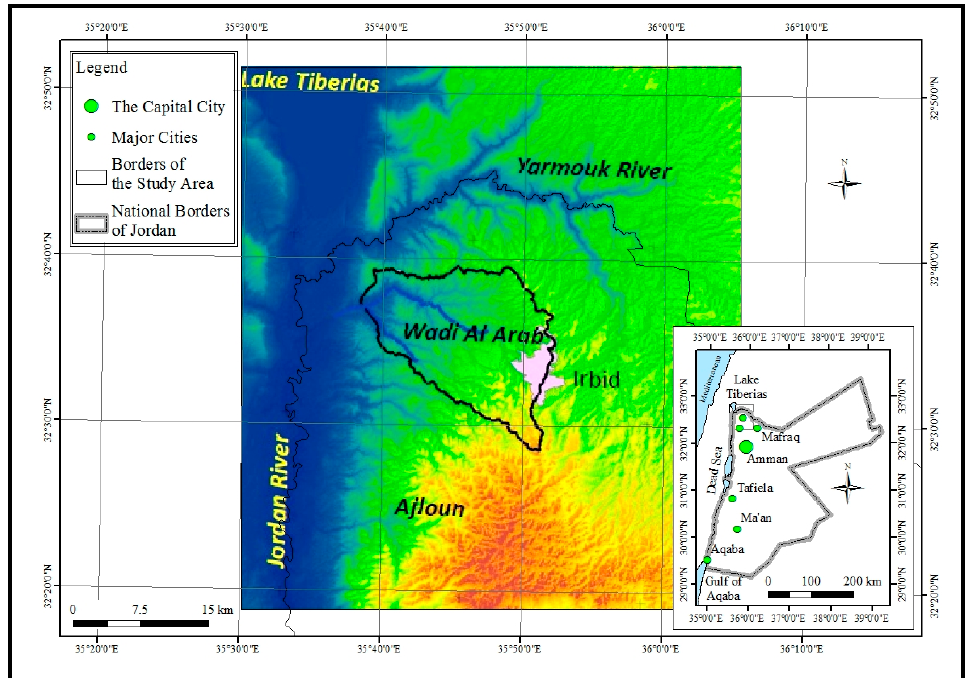
Figure 1. Location map of Wadi Al Arab Well Field [15].